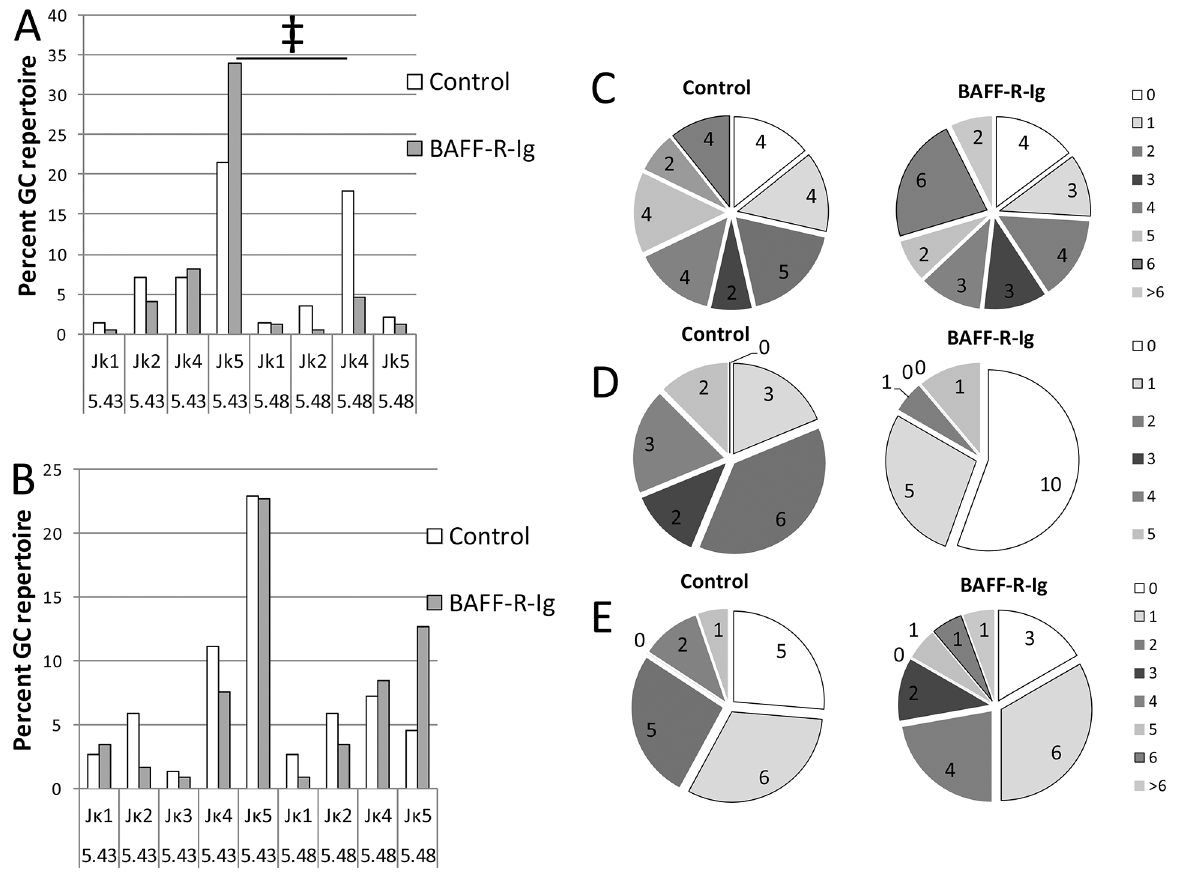
Figure 6. Distribution of J κ regions among V κ 5-45– and V κ 5-48– encoded light chains as a percentage of total GC light chains is shown in NZW/BXSB (A) and NZB/W (B) chimeras. The ratio of the two dominant light chains V κ 5-43/45/J κ 5 and V κ 5-48/J κ 4 is reversed in NZW/BXSB mice treated with BAFF-R-Ig (‡ p < 0.01). C–E show the mutation frequency per sequence for NZW/BXSB V κ 5-43 (C), NZB/W V κ 5-43 (D) and NZB/W V κ 5-48